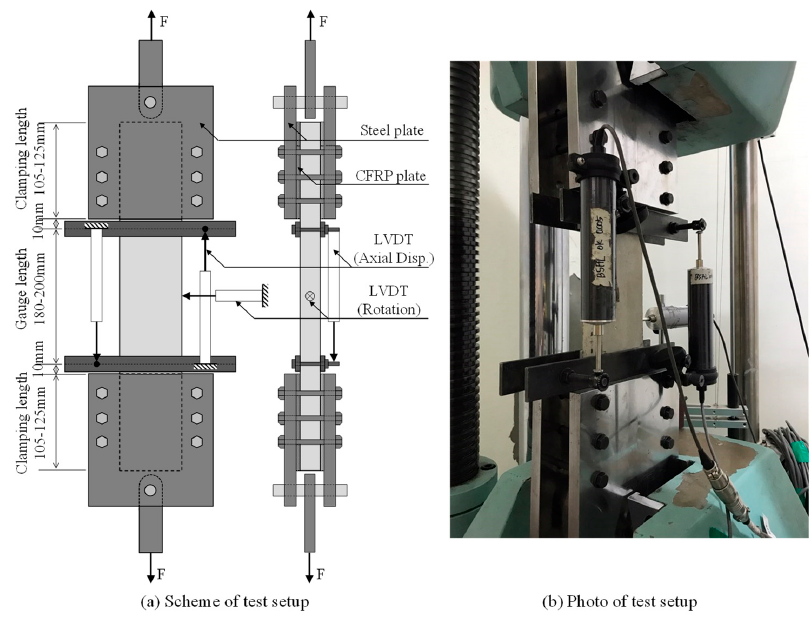
Materials 2019 , 12 , x FOR PEER REVIEW